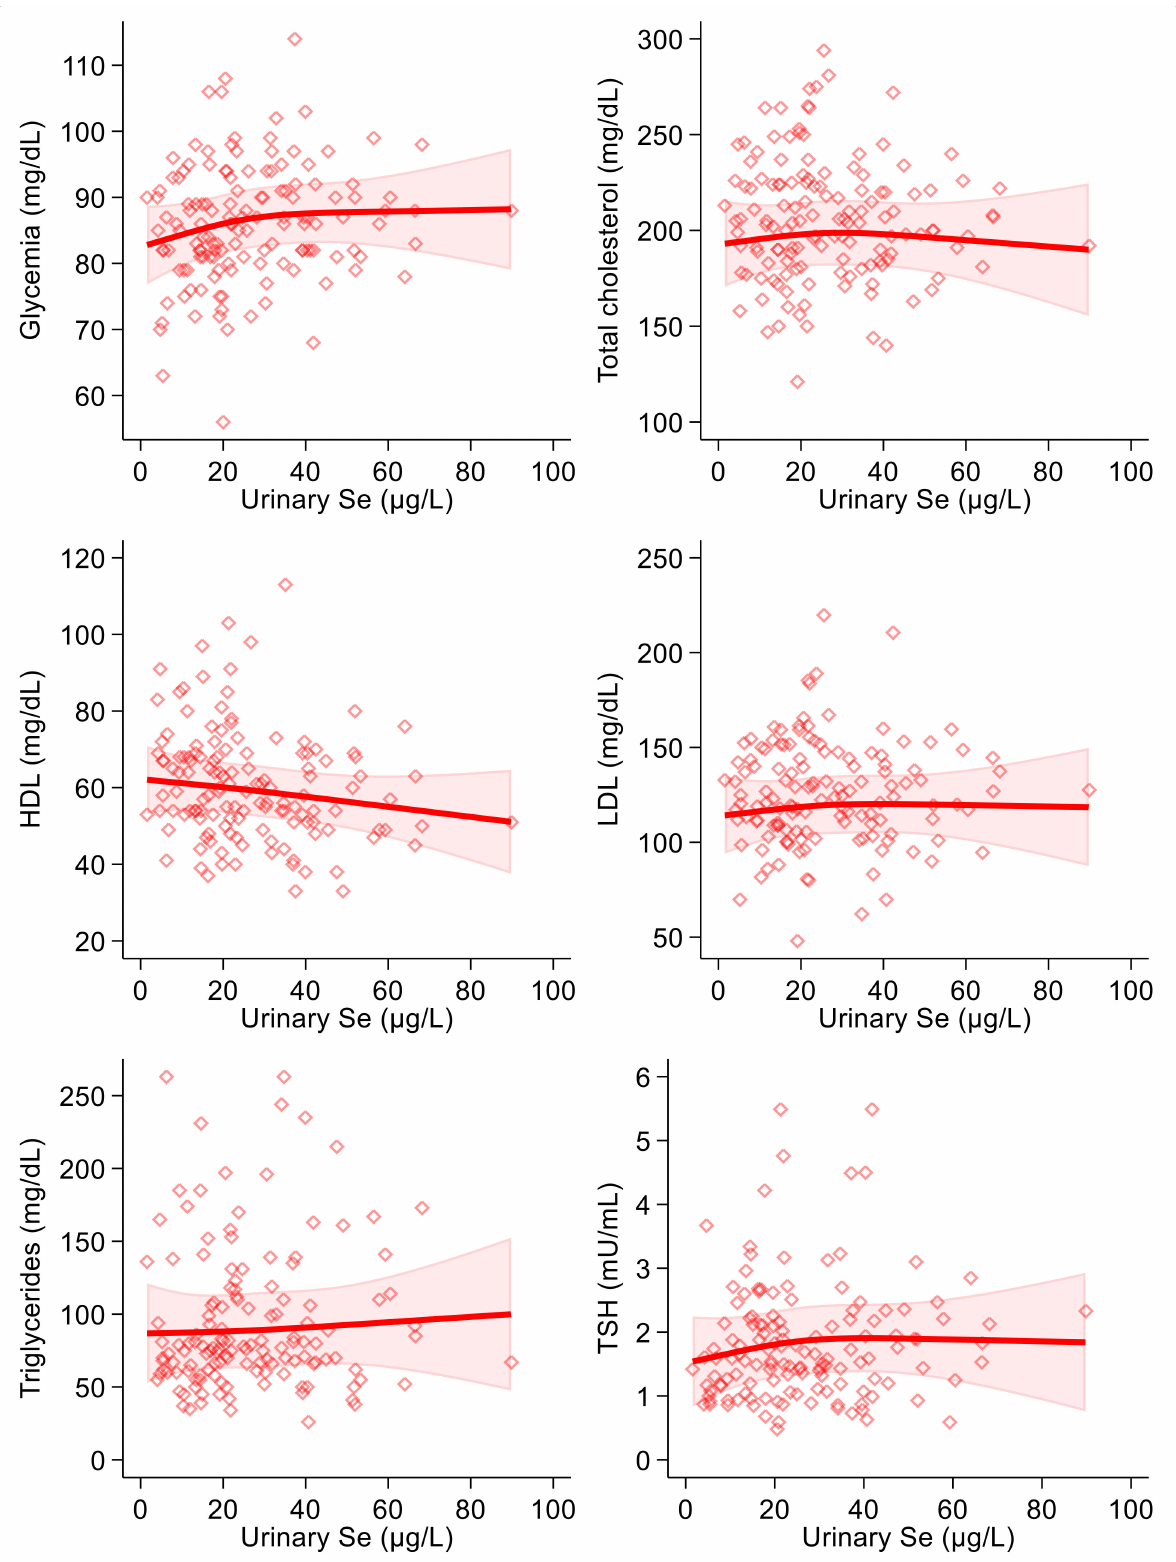
Figure 3. Spline regression analysis of dietary selenium (Se) levels, glycemic and lipid profile variables and thyroid- stimulating hormone (TSH). Solid lines represent multivariable analysis (adjusted for age, sex, body mass index, cotinine levels and alcohol intake) and the shaded area indicates upper and lower confidence interval